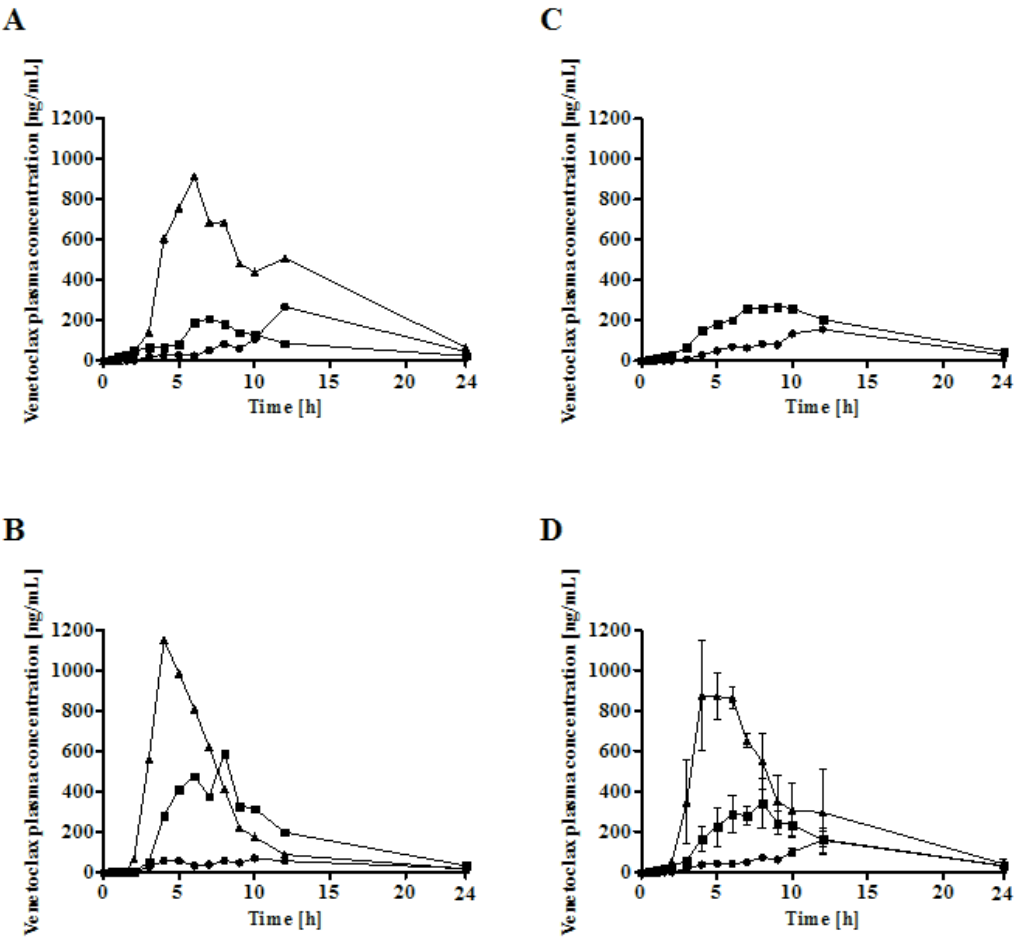
Figure 7. Venetoclax plasma concentration versus time profiles from 0 to 24 h for 100 mg venetoclax in male landrace pigs. Venetoclax powder capsule (●), Peceol ® suspension (5% w / v ) ( ■ ), and sLBF (5% w / v ) ( ▲ ). ( A – C ): Individual plasma concentration versus time profiles. ( D ): Mean plasma concentration versus time profiles.